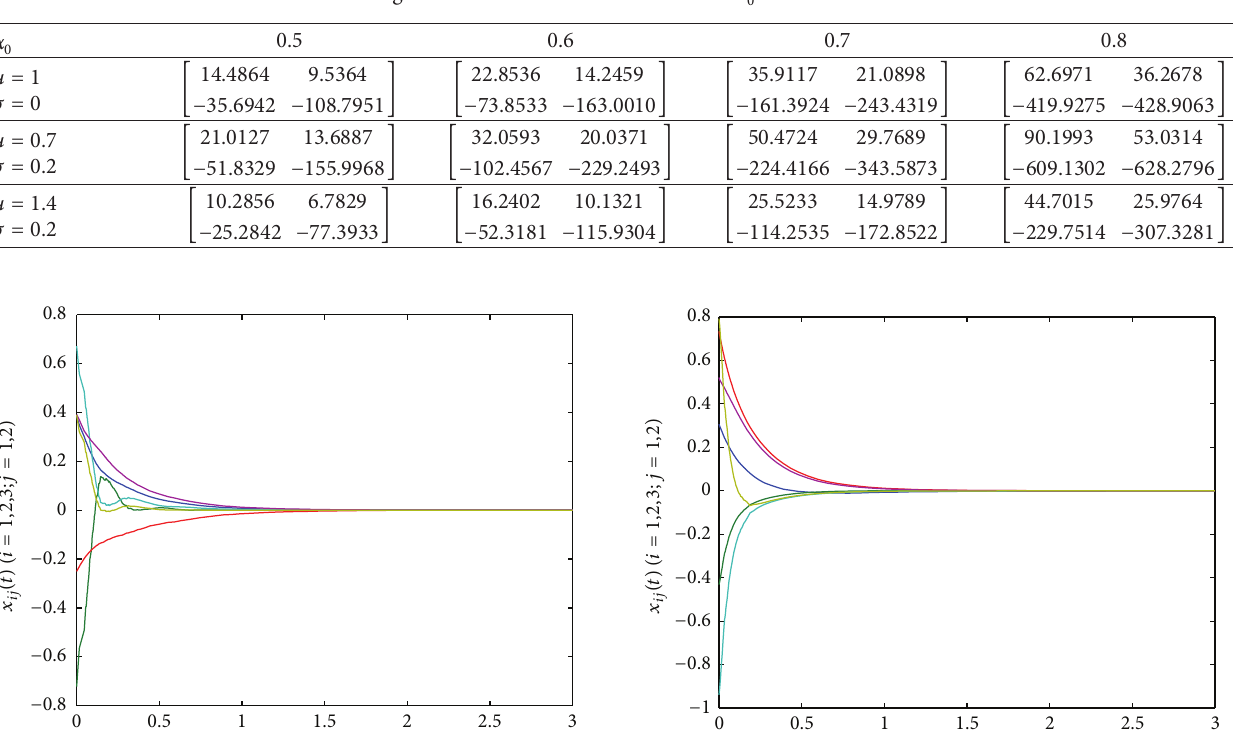
Table 3: The feedback gain matrices 𝐾 for different values of 𝛼 0 and the conditions of actuator.